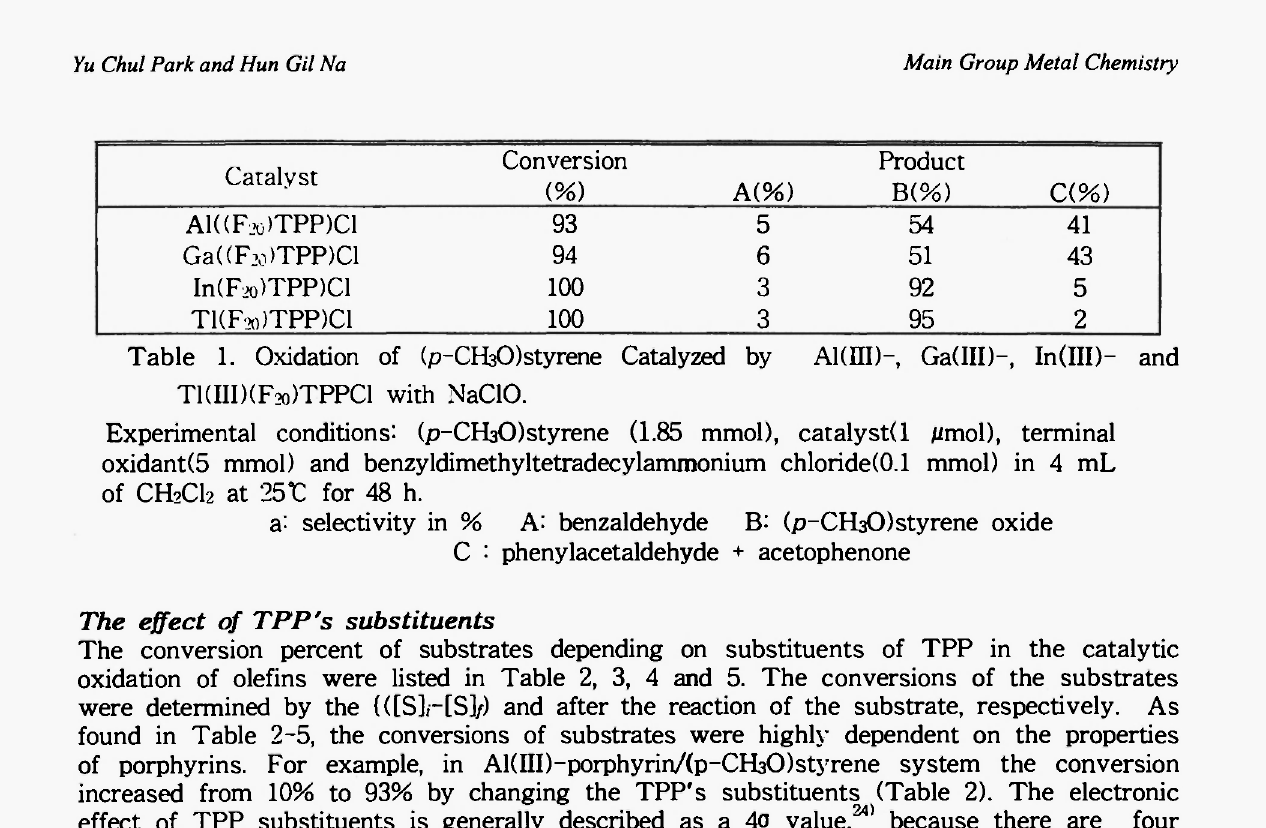
1. Oxidation of (p-CHsOtetyrene Catalyzed by and T1(III)(F 2O )TPPC1 with NaClO.